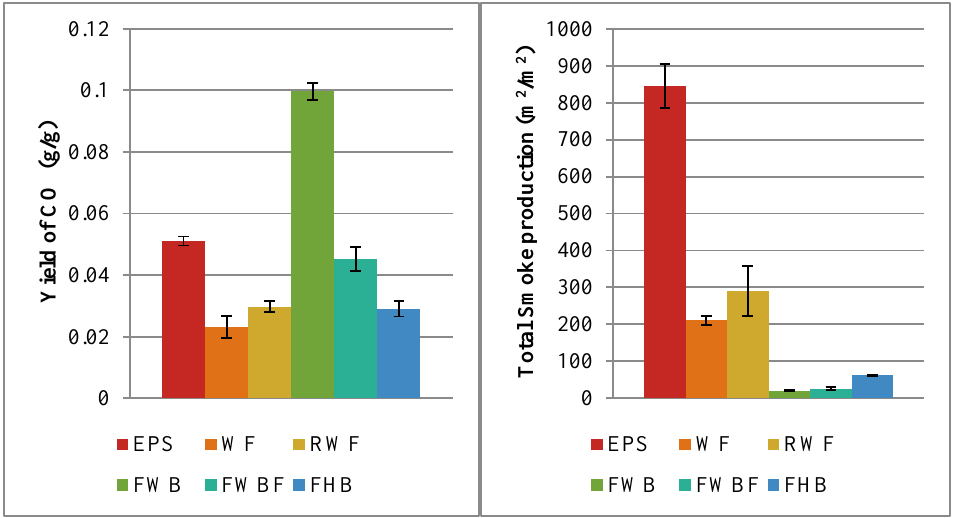
Figure 4. Time to ignition, peak of heat release rate, carbon monoxide yield and total smoke release for EPS and five bio-based insulation materials, determined via the cone calorimeter test. 205